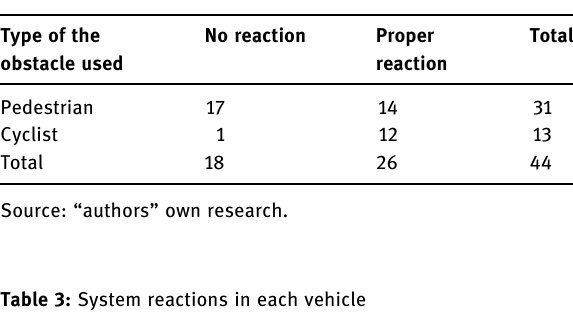
Figure 14: Reactions of the AEB system in the individual scenarios. Source: “ authors ” own study.